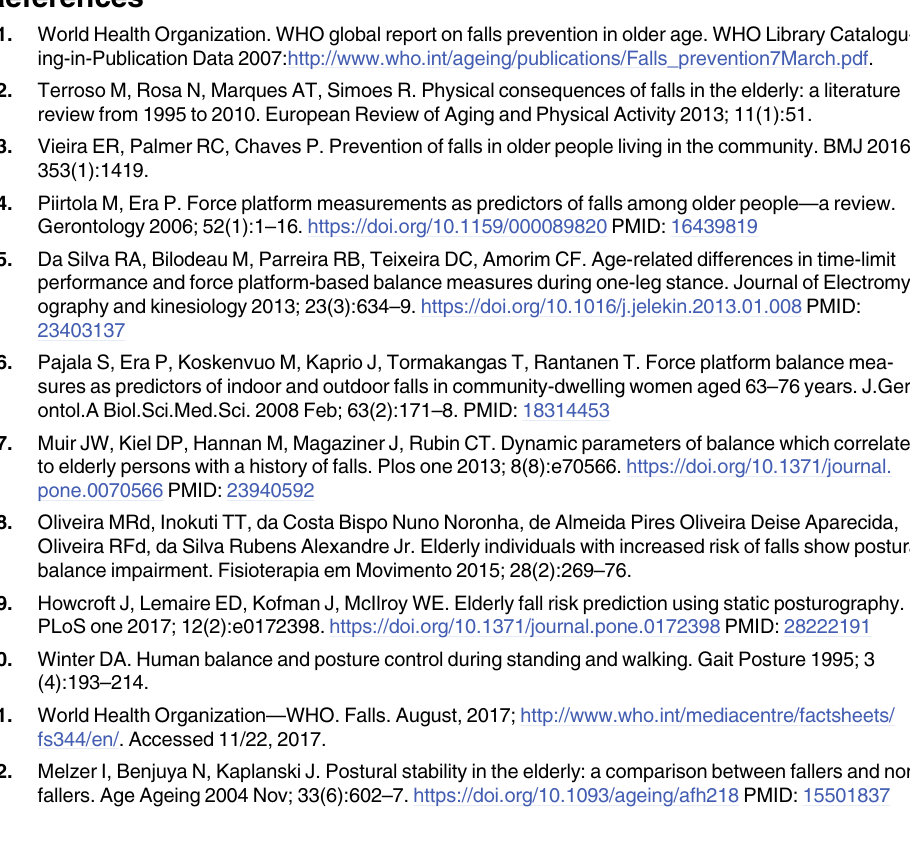
S3 Fig. Receiver operating curve to center of pressure velocity in the mediolateral (VEL M/ L)